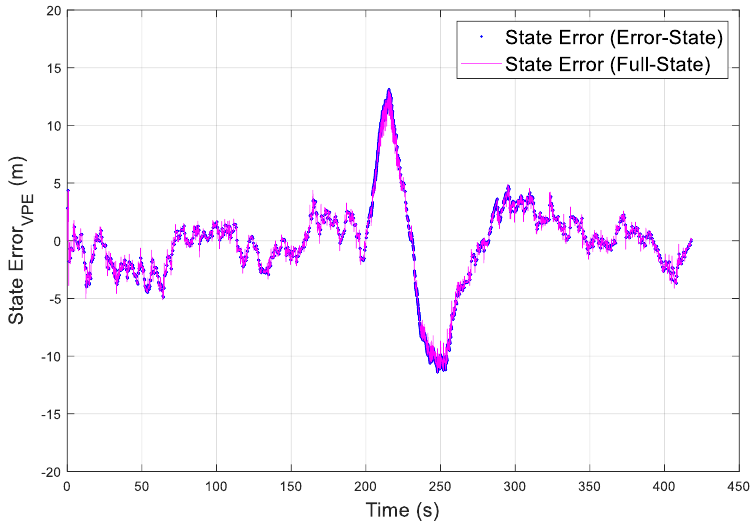
Figure 5. Simulation of the vertical position state error.